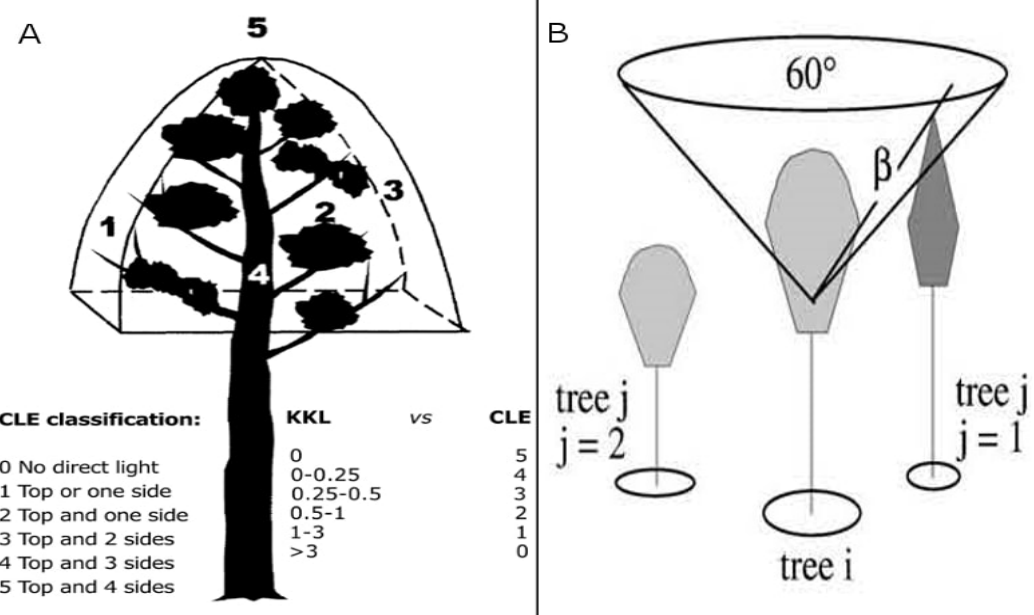
Figure 2. Crown light exposure (CLE) classification ( A ) and calculation of the competition index CCS (crown competition for sunlight) based on Pretzsch et al. ( B ). In the bottom right corner of ( A ), the conversion of CCS is indicated in CLE values. Sources: [19,31].